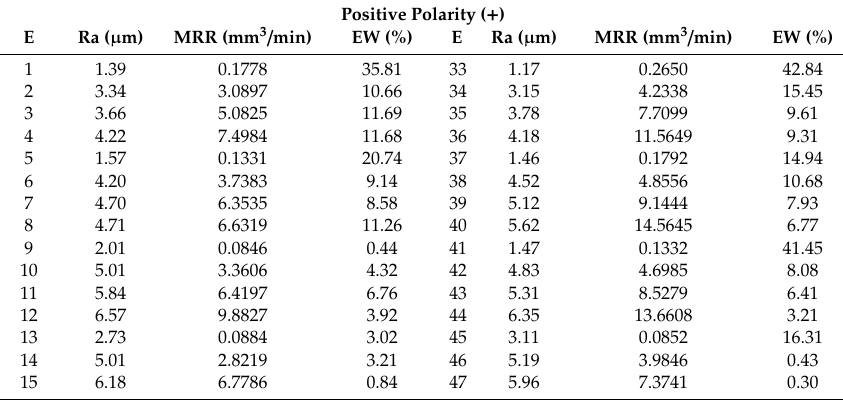
Table A1. Mean values of Ra, MRR, and EW, obtained with positive polarity. These values were taken from Reference [2] Torres Salcedo, A.; Puertas Arbizu I.; Luis P é rez, C. J. Analytical Modeling of Energy Density and Optimization of the EDM Machining Parameters of Inconel 600. Metals 2017, 7, 166. (CC BY) license: http: // creativecommons.org / licenses / by / 4.0 /